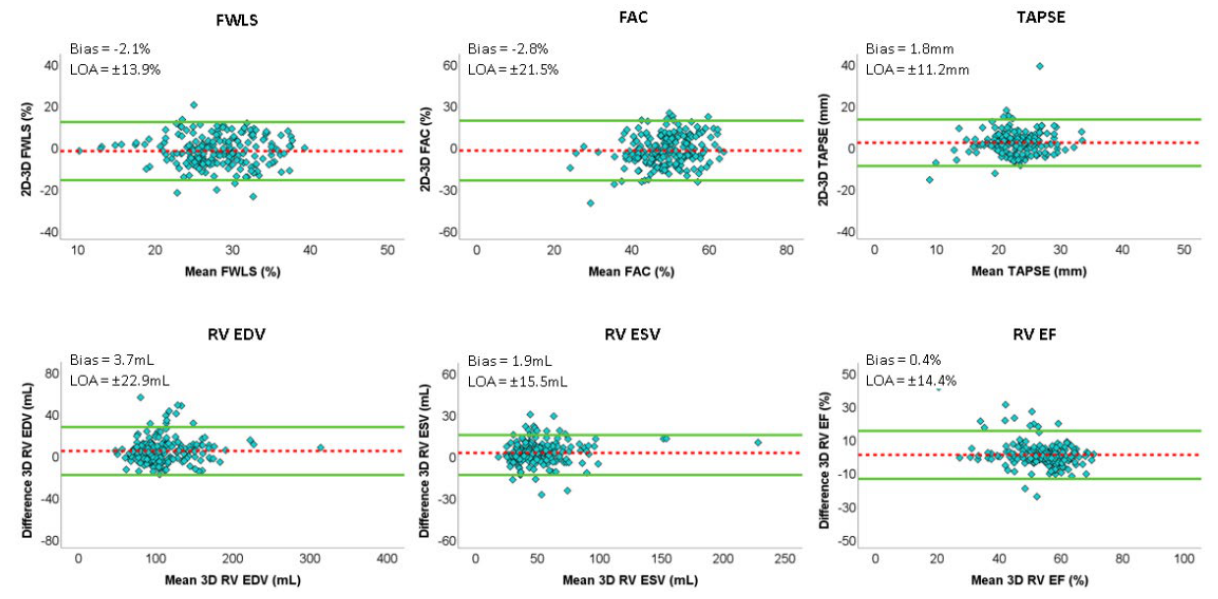
Figure 2. Top panels: results of Bland–Altman analysis for right ventricular free wall longitudinal strain (FWLS), right ventricular fractional area change (RV FAC) tricuspid annular plane systolic excursion (TAPSE) obtained from automatic and semi–automatic 2–dimensional methods. Bottom panels: Results of Bland–Altman analysis for right ventricular end–diastolic volume (RV EDV), right ventricular end–systolic volume (RV ESV) and right ventricular ejection fraction (RV EF) obtained from automatic and semi-automatic methods. Dashed line = bias; solid line = ± 2 standard deviations; LOA: limits of agreement.